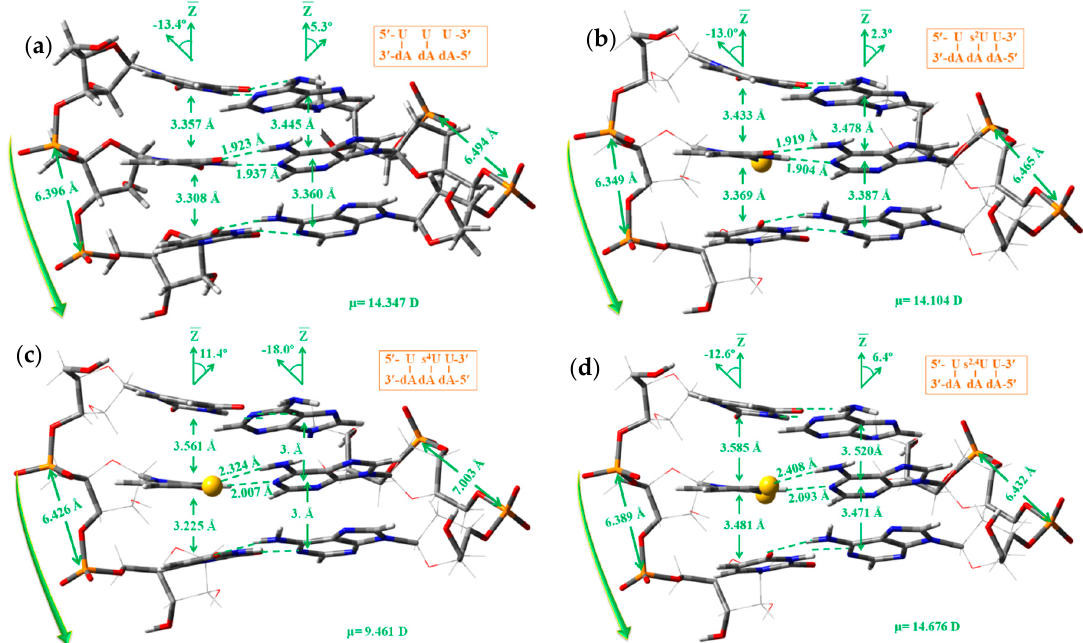
Figure 9. Graphical comparison of the differences in the spatial orientation, and in the base pairs, base step and helical parameters in the microhelixes A-type with three nucleotide base pairs, with uridine or a thio-nucleotide in the plane “n” of strand I : ( a ) With uridine in 5 ′ -UUU-3 ′ ; ( b ) with 2-thiouridine in 5 ′ -U s 2 U U-3 ′ ; ( c ) with 4-thiouridine in 5 ′ -U s 4 U U-3 ′ and ( d ) with 2,4-dithiouridine in 5 ′ -U s 2,4 U U-3 ′ .